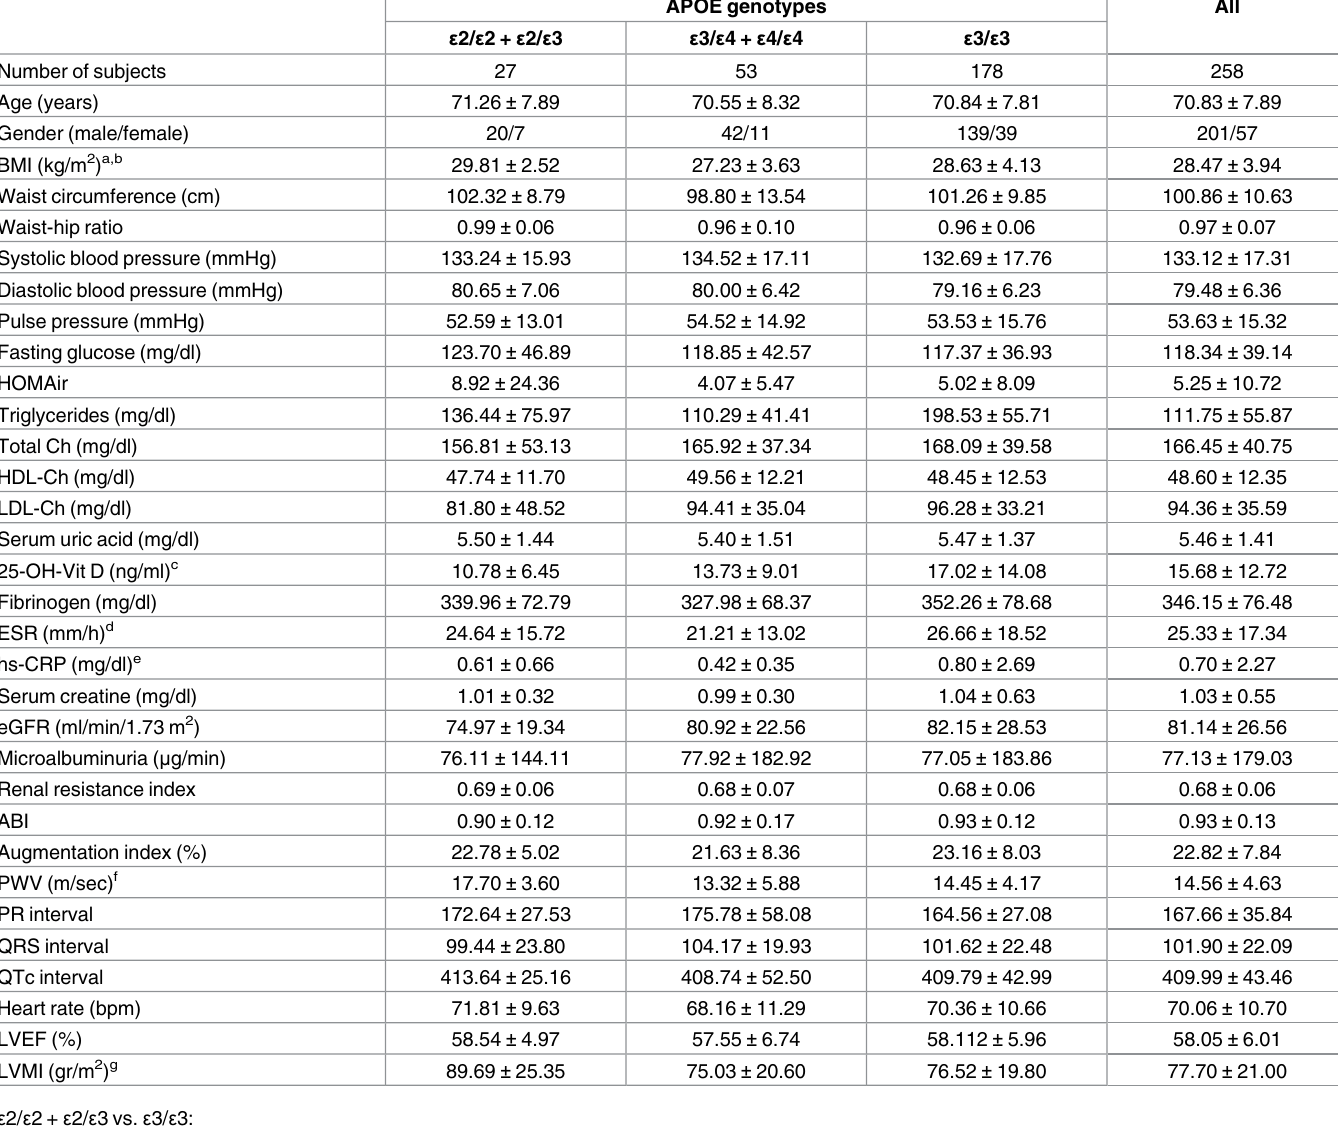
Table 1. Demographic and clinical characteristics of patients at baseline according to APOE